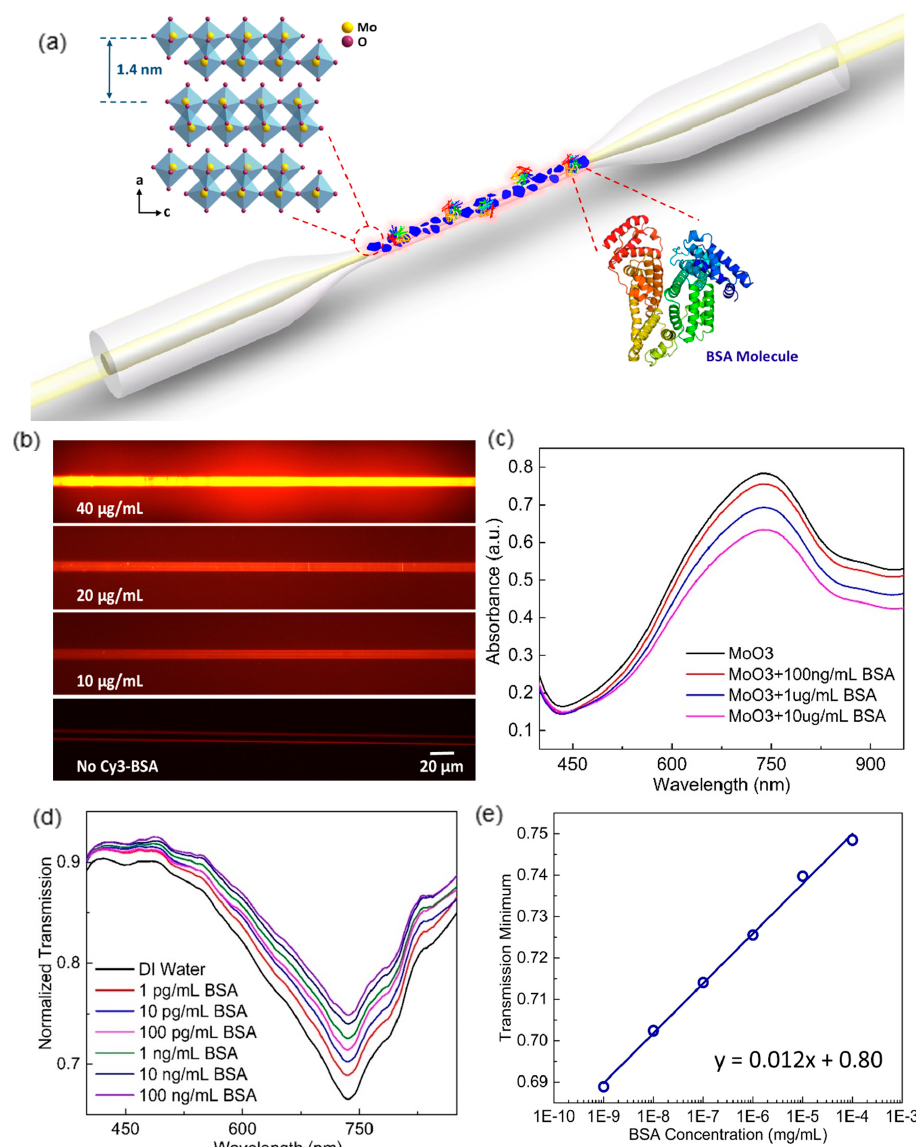
Figure 9. ( a ) The schematic illustration of heavily-doped MoO 3 − x nanoflakes based hybrid fiber-optic plasmonic biosensor. (Inset 1) The crystal structure of α -MoO 3 lattice. (Inset 2) Molecular structure